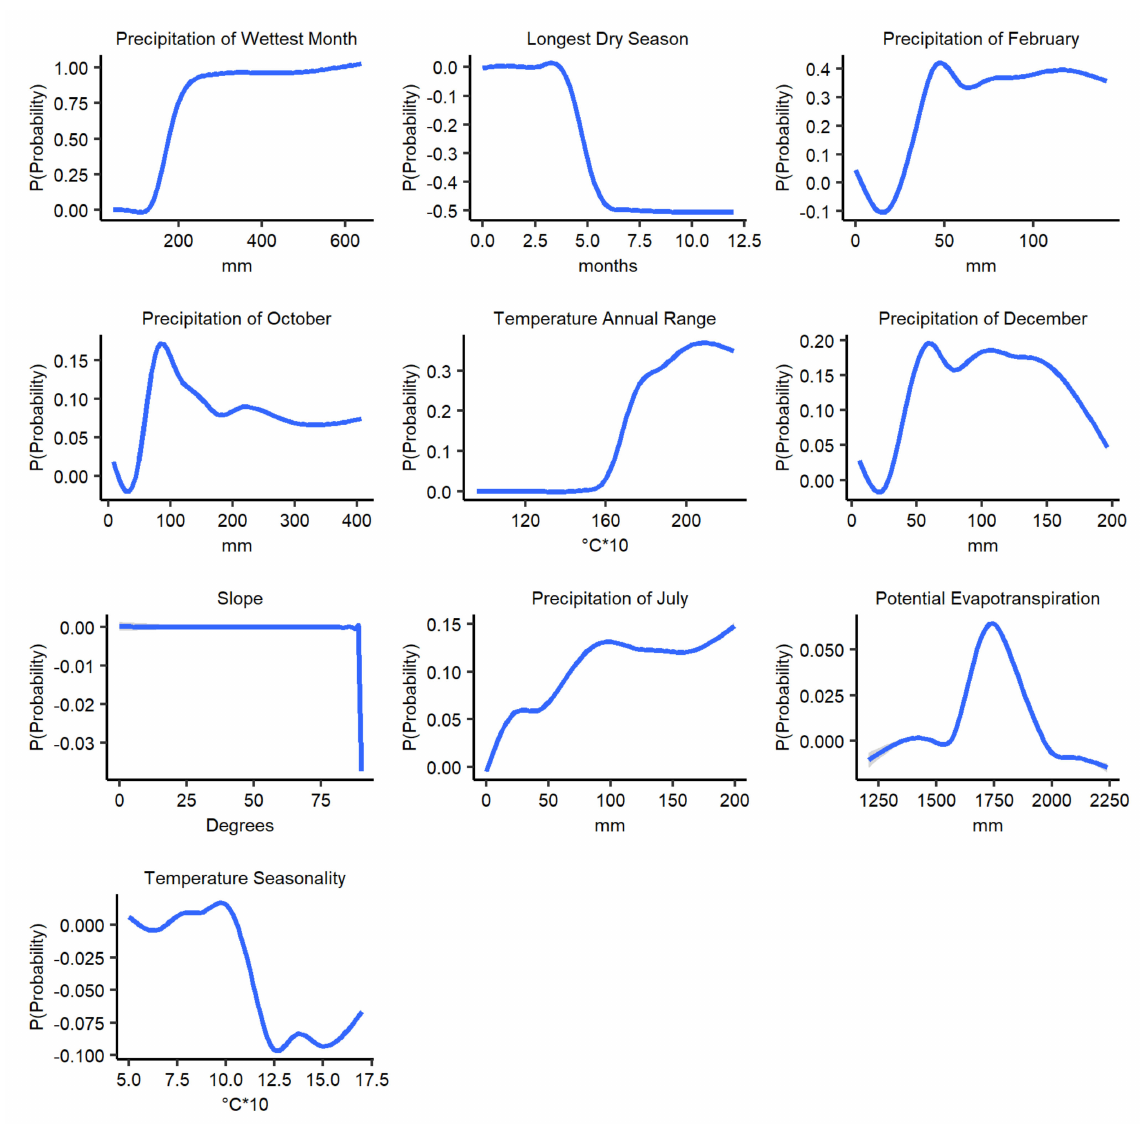
Figure 4. Partial dependency plots (PDP) showing marginal effects on the prediction probability of potential anthrax distribution by each variable across the 100 BRT experiments for current climatic